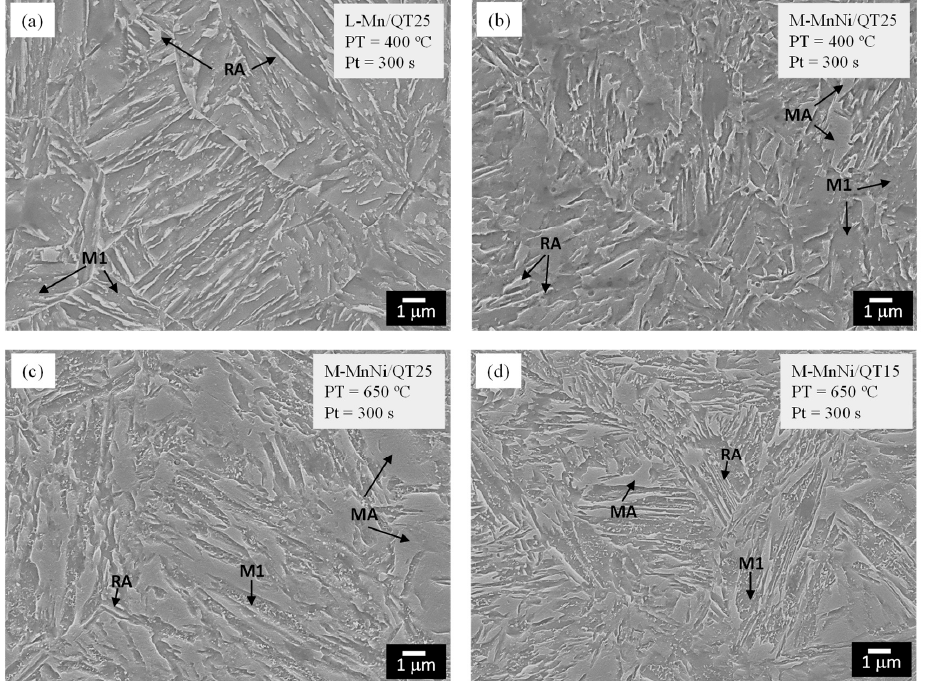
Figure 6. Field emission gun scanning electron microscopy (FEGSEM) micrographs